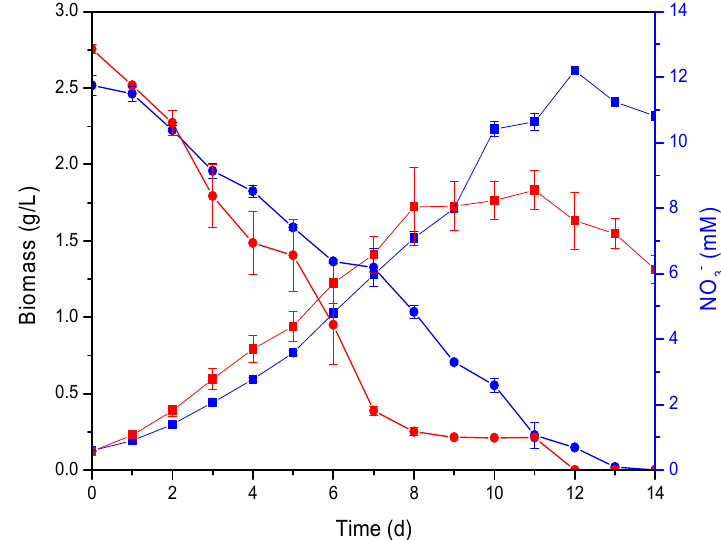
Figure 2. Growth curves (squares) and nitrate uptake (circles) for cultures of P. tricornutum under an 18:6-h photoperiod with continuous CO 2 injection (blue symbols) and without CO 2 injection (red symbols).